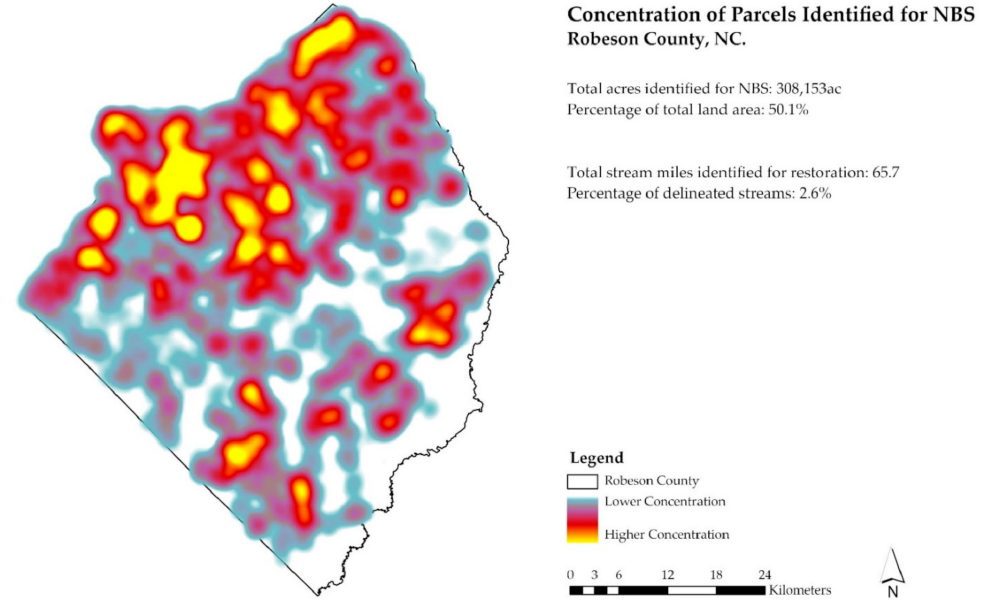
Figure 17. Symbolizing the concentrations of opportunity area parcels as a heat map better illus- trates spatial patterns of clustering and helps identify hotspots where implementation of FloodWise practices can be